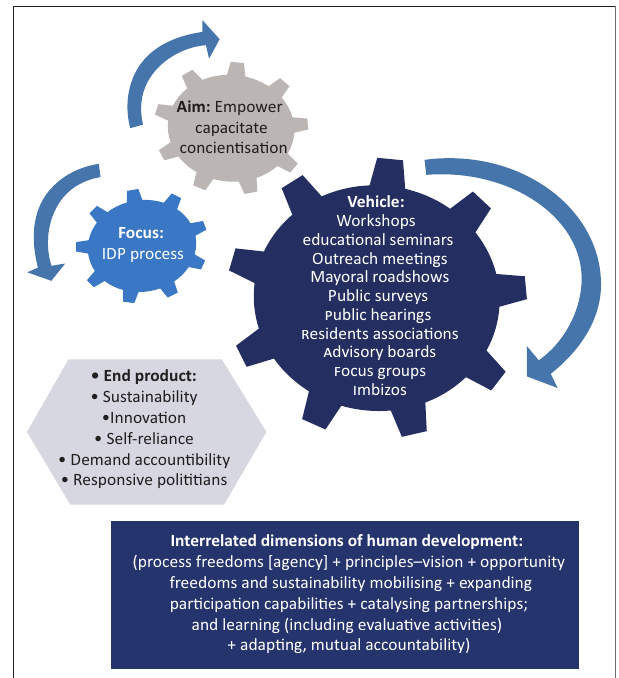
FIGURE 1: A local governance framework for enhancing community voice in public participation platforms and